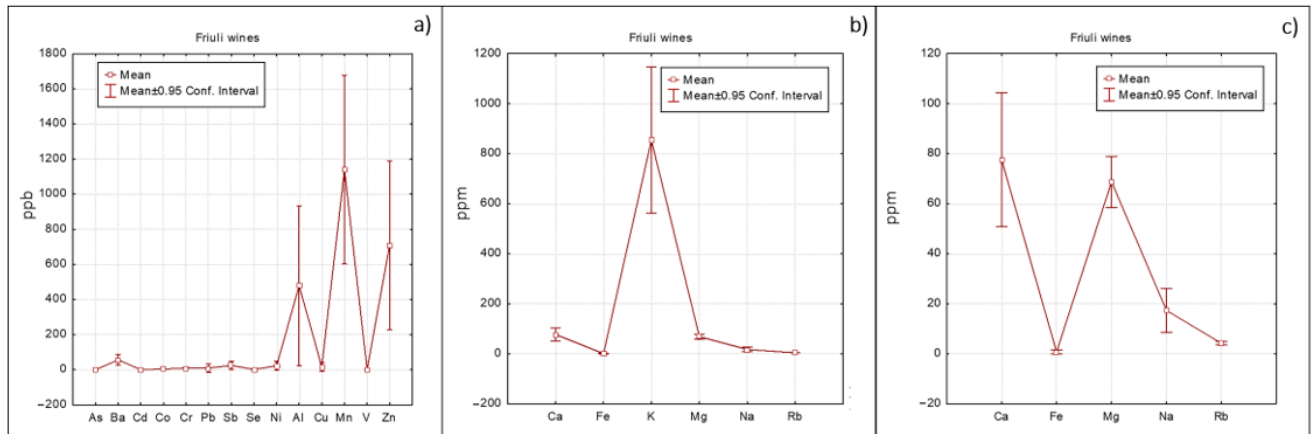
Figure 3. Elements trend concentration for Friuli wines: ( a ) minor elements, ( b ) major elements and ( c ) major elements excluding K.